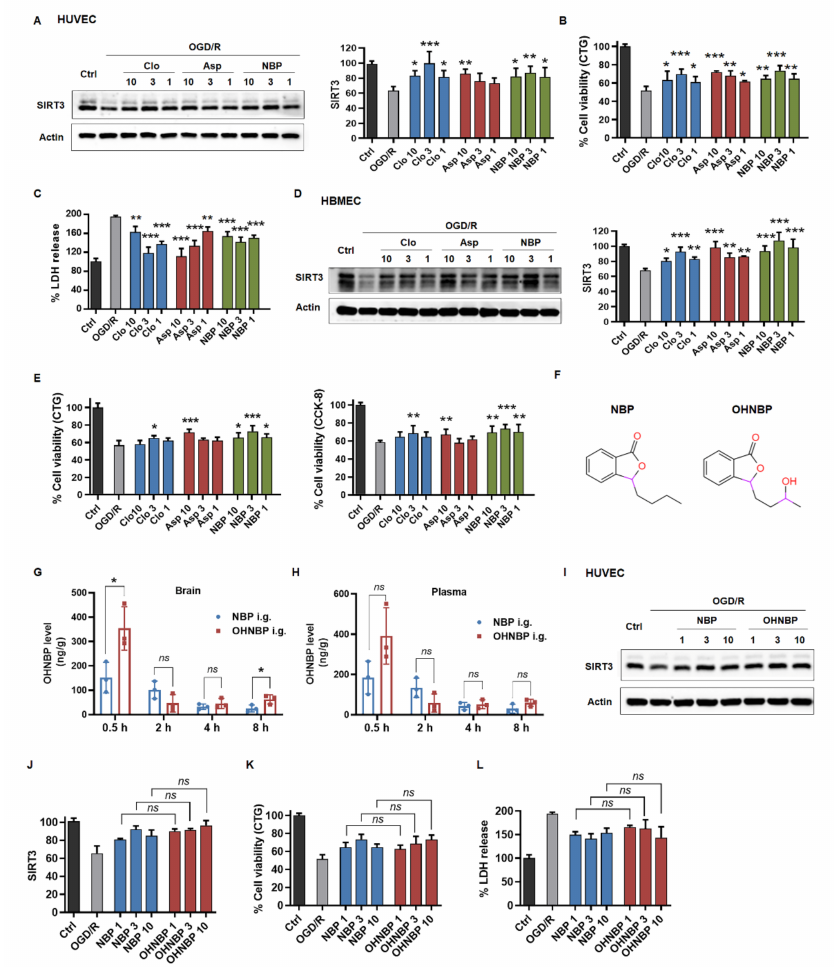
Figure 4. Clinical drugs rescue SIRT3 to reduce OGD/R-induced injury. ( A ) The effect of Clo, Asp and NBP on SIRT3 expression in HUVECs after exposure to OGD/R as assessed by Western blotting. ( B , C ) The effect of Clo, Asp and NBP on cell viability in HUVECs after exposure to OGD/R by using CTG assay or LDH kit. ( D ) The effect of Clo, Asp and NBP on SIRT3 expression in HBMECs after exposure to OGD/R as assessed by Western blotting. ( E ) The effect of Clo, Asp and NBP on cell viability in HBMECs after exposure to OGD/R by using CTG or CCK-8 assay. ( F ) Chemical design of OHNBP. ( G , H ) The concentration of OHNBP was detected in plasma and brain after 20 mg/kg OH-NBP or NBP was administered to SD rats via oral gavage. ( I , J ) The effect of OHNBP and NBP on SIRT3 expression in HUVECs after exposure to OGD/R as assessed by Western blotting. ( K , L ) The effect of OHNBP and NBP on cell viability in HUVECs after exposure to OGD/R by using CTG assay or LDH kit. The data are presented as the means ± SD, and were assessed using one-way ANOVA. * p < 0.05 vs. the OGD/R group, ** p < 0.01 vs. the OGD/R group, *** p < 0.001 vs. the OGD/R group. ns, no significance. n = 3 for